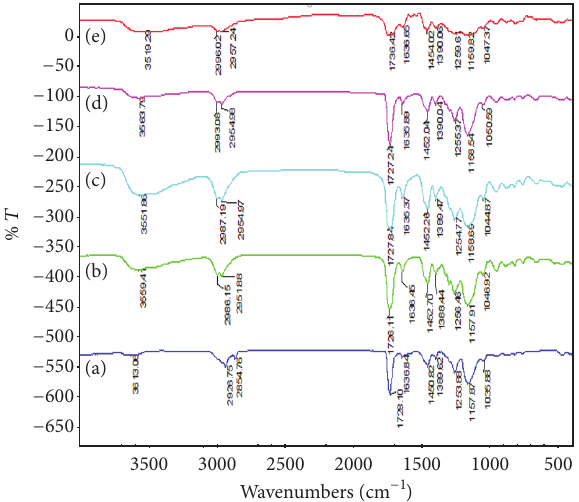
Figure 1: FT-IR spectra, (a) MIP 1, (b) MIP 2, (c) MIP 3, (d) MIP 4, and (e) NIP.